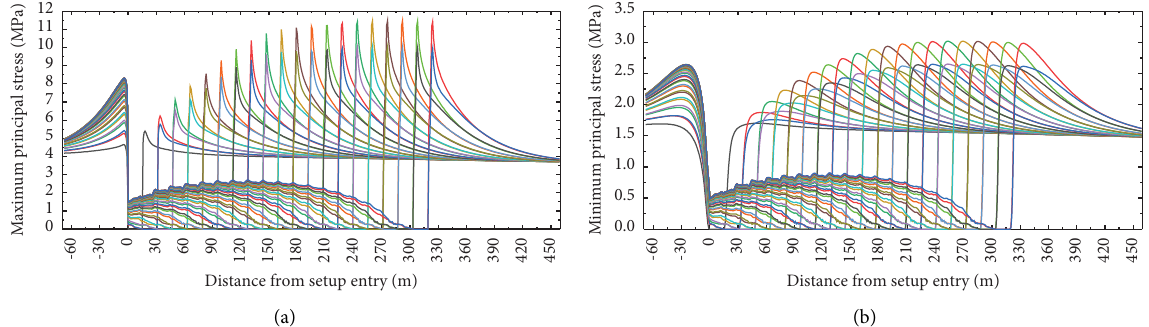
Figure 5: Evolution characteristics of principal stress during mining, (a) maximum principal stress, (b) minimum principal stress.